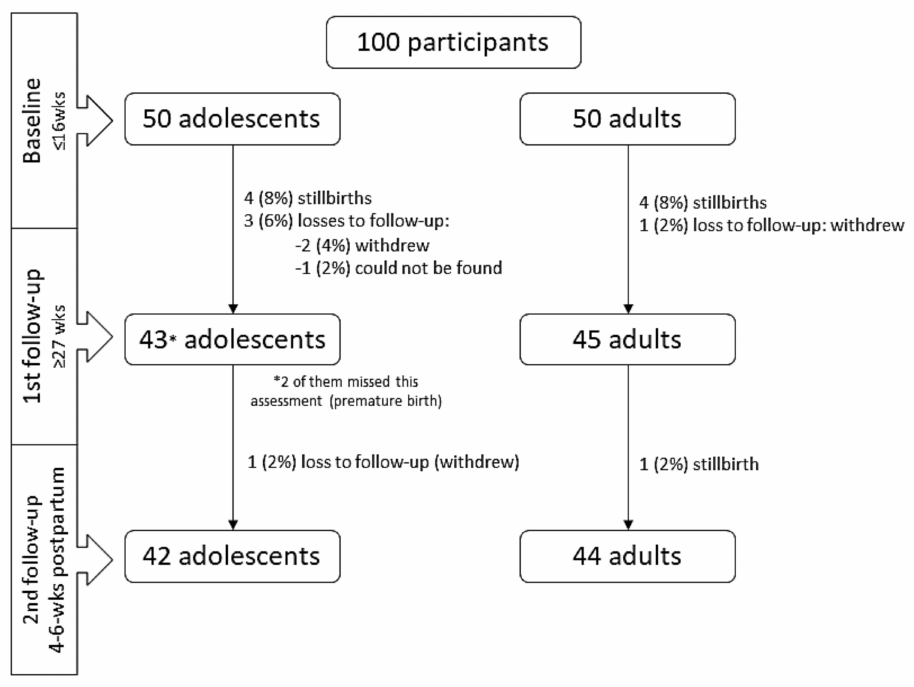
Figure 1. Flowchart of the sample by age group of AMOR project in the Trairi region, Rio Grande do Norte, Brazil, 2017–2019. * Two participants were not assessed in the 1st follow-up because of premature birth but they returned for the 2nd